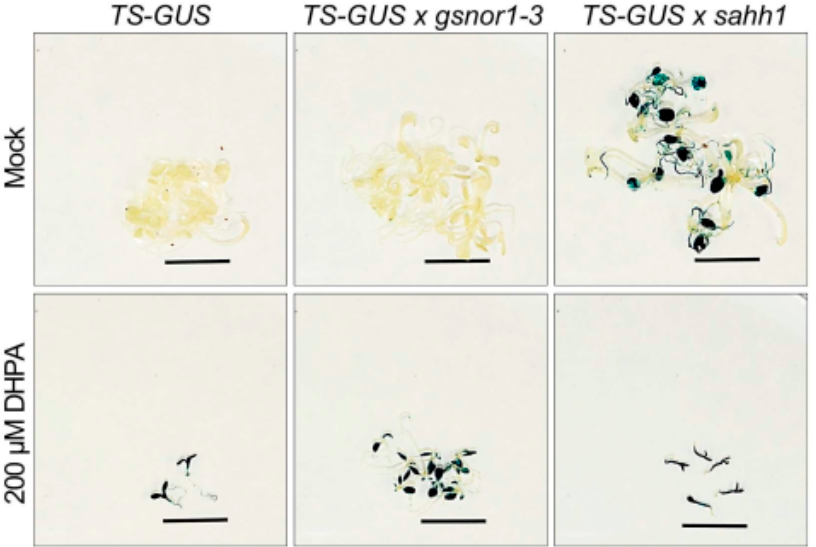
Figure 3. Reactivation of TS-GUS in gsnor1-3 and sahh1 . Blue staining indicates release of gene silencing. Plantlets were grown in liquid 1 × MS under short-day conditions supplemented with water (mock) as control, or seedlings were grown in the presence of 200 µ M DHPA. Due to DHPA, reduced growth is observed as previously demonstrated [53]. GUS reactivation was visible in sahh1 but not in the gsnor1-3 background. Treatments with the SAHH inhibitor DHPA released TS-GUS silencing in all mutant backgrounds. Scale bar = 1 cm.